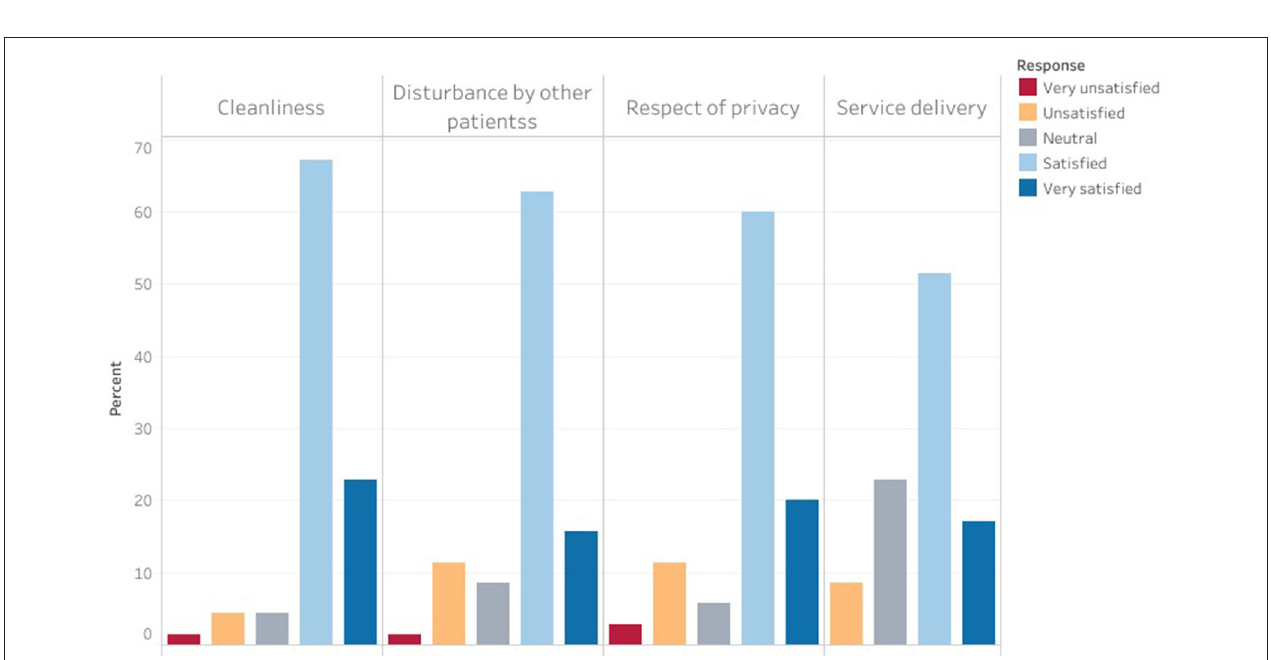
FIGURE 4 | Factors influencing the quality of care and service delivery.